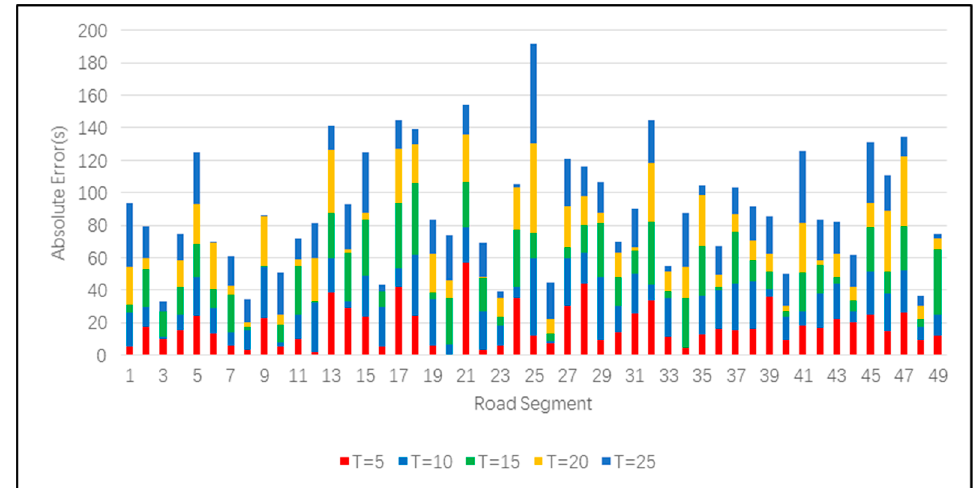
Figure 4. A comparison of the true and predicted values of a data series extracted from the test set. Predictions using dynamic factors are closer to real values than predictions that do not use dynamic factors.